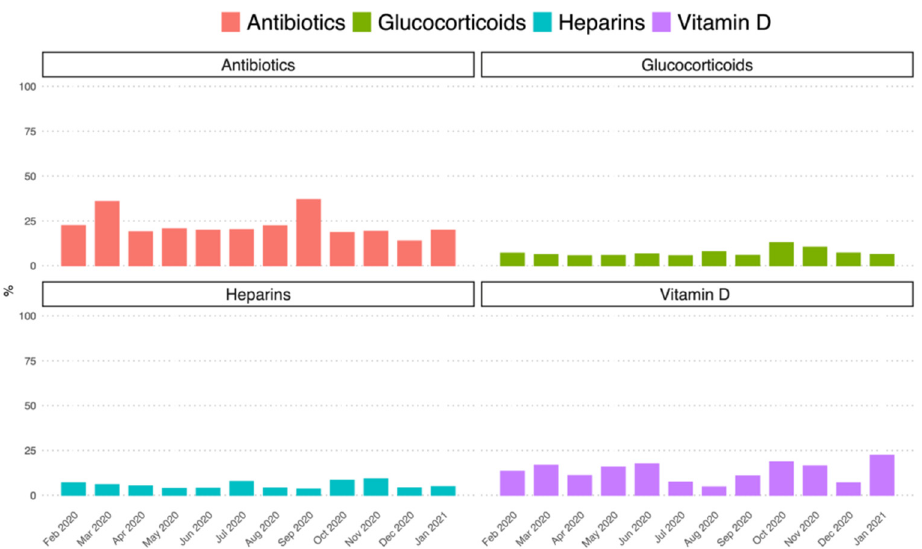
Figure 3. Frequency (%) of study drugs purchased privately in Caserta Local Health Unit on the